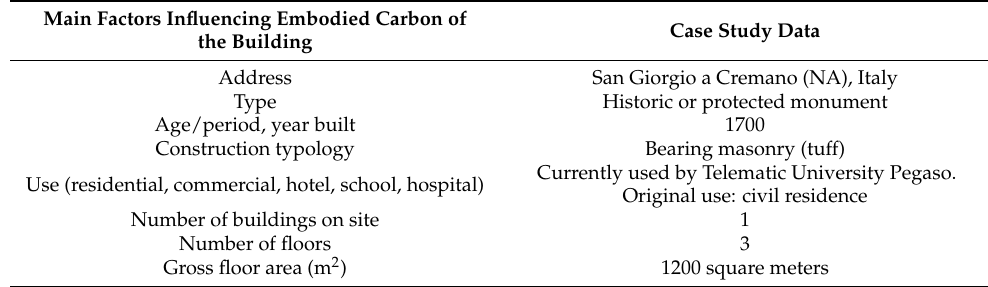
Table 4. BIM modelling basic